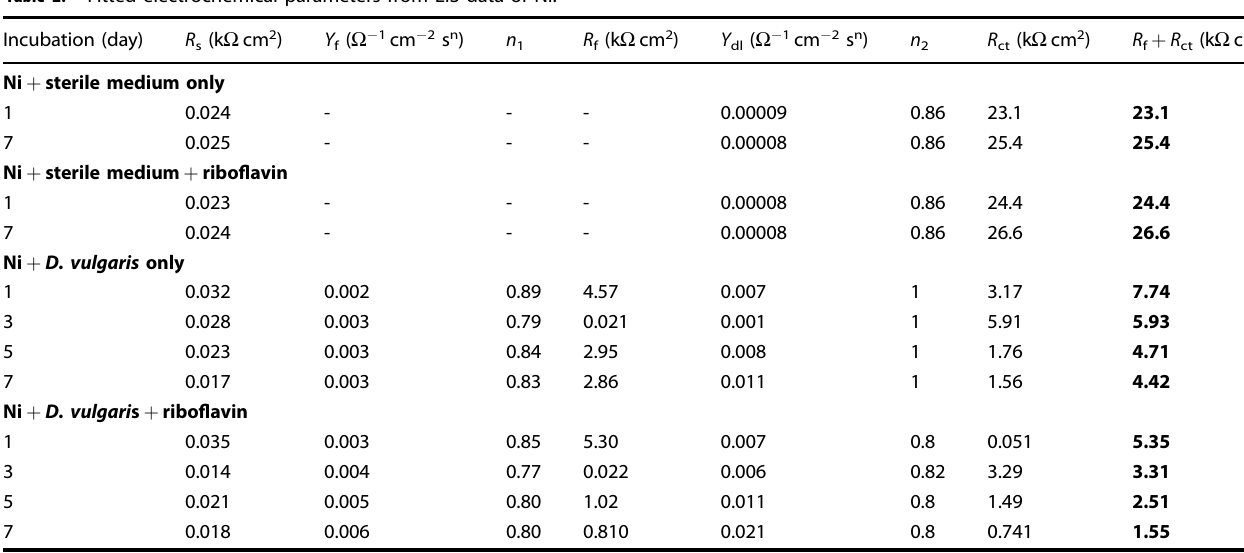
Table 2. Fitted electrochemical parameters from EIS data of